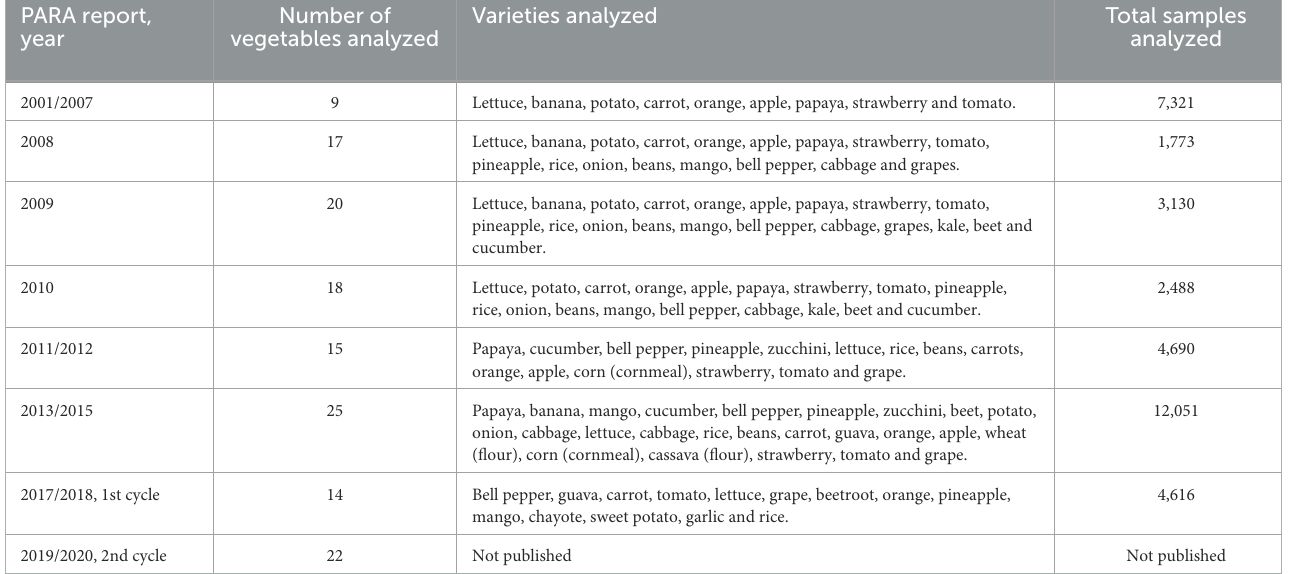
TABLE 1 Historical overview of the sampling of in natura foods carried out in PARA